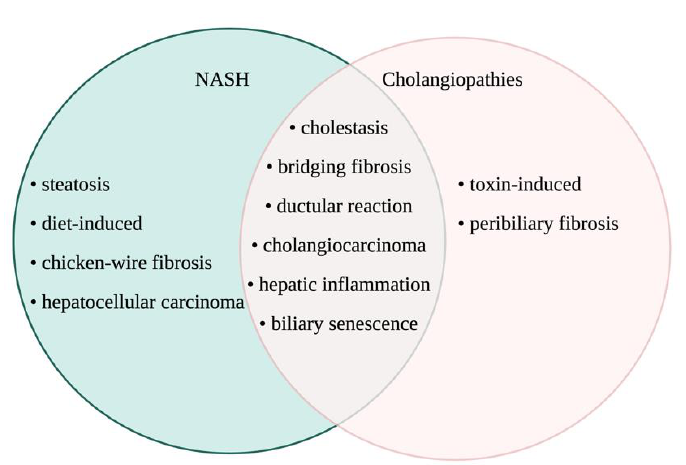
Figure 5. Liver phenotypes between NASH and cholangiopathies. Despite not being considered as a classic disease of the biliary epithelium, NASH shares common etiology and phenotype with cholangiopathies. This Venn diagram presents the comparative scenario on how NASH can be considered a pathological condition of the biliary epithelium owing to prominence of the most common features of cholangiopathies like PSC, PBC, and biliary atresia. Image made with BioRender (https://biorender.com/).